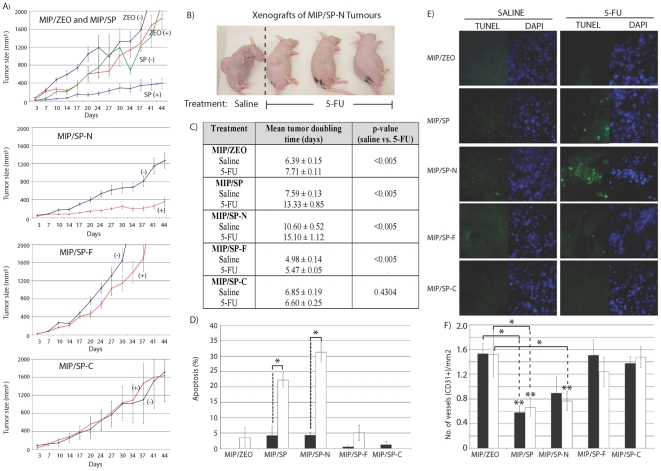
Xenografts overexpressing SP-N have greater tumor regression and apoptosis in response to 5-FU.
A,B) Comparison of tumor size in xenografts from MIP/SP-N, MIP/SP-F, MIP/SP-C, and MIP/ZEO cells with or without treatment with 5-FU; “+” = 5-FU-treatment; “−” = saline-treatment, (n = 14/group; mean ± s.e). C) Tumor doubling times of xenografts following 5-FU treatment. (D) Percentage of apoptotic cells detected by TUNEL staining [representative images in (E)]. (F) number of CD31-positive stained blood vessels in the tumor xenografts of (▪) saline or (□) 5-FU-treated animals. Student's t-test * p<0.05, ** p<0.01.